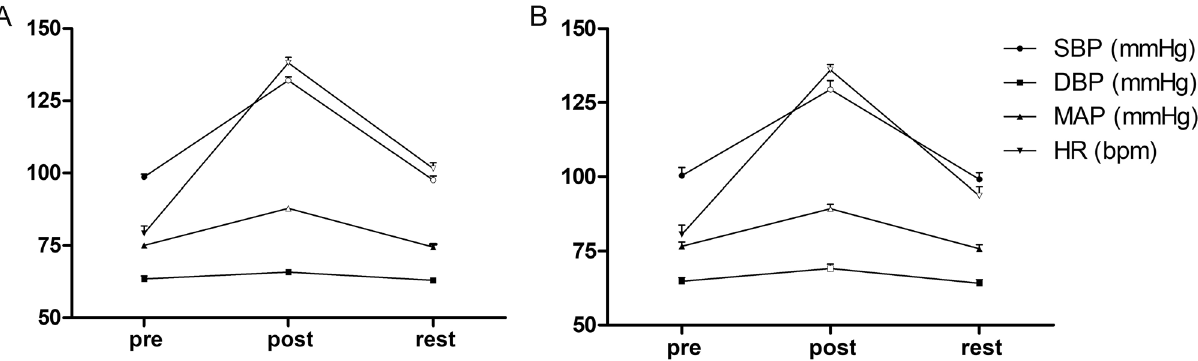
Figure 1. Changes in systemic dynamic parameters among measurements obtained before the 20 min of cycling exercise, immediately after the exercise, and after the 30-min rest period. ( A ) Systemic dynamic parameters of myopic group. ( B ) Systemic dynamic parameters of emmetropic group. The error bars represent the standard error of the mean, all compared with the data before exercise (hollow symbols represent p < 0.001 vs. pre-exercise). SBP systolic blood pressure; DBP diastolic blood pressure, MAP mean arterial pressure, HR heart